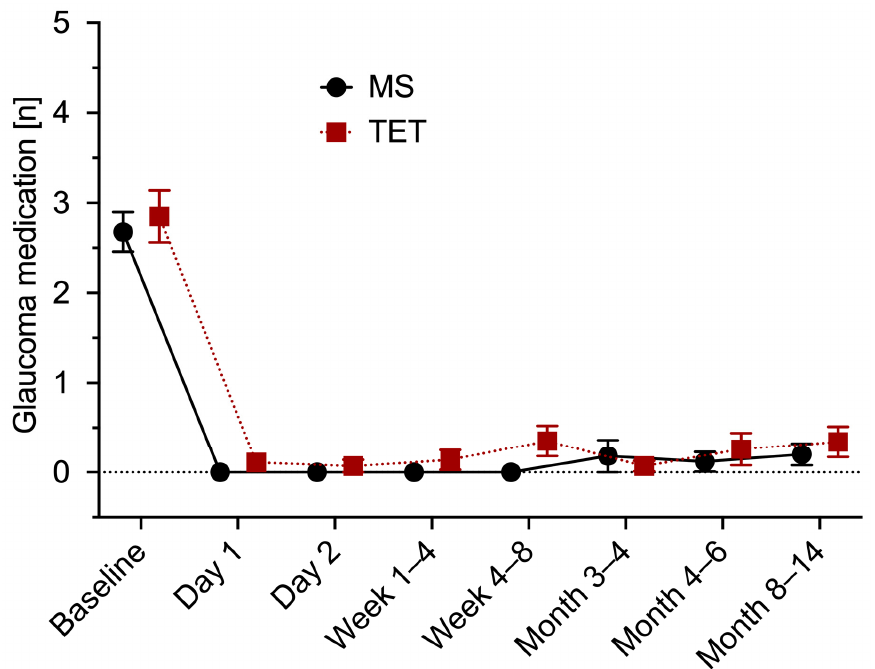
Figure 4. Medical therapy. Mean and standard error of the mean of the number of antiglaucomatous medications at each time of follow-up for MicroShunt implantation (MS) and trabeculectomy (TET).